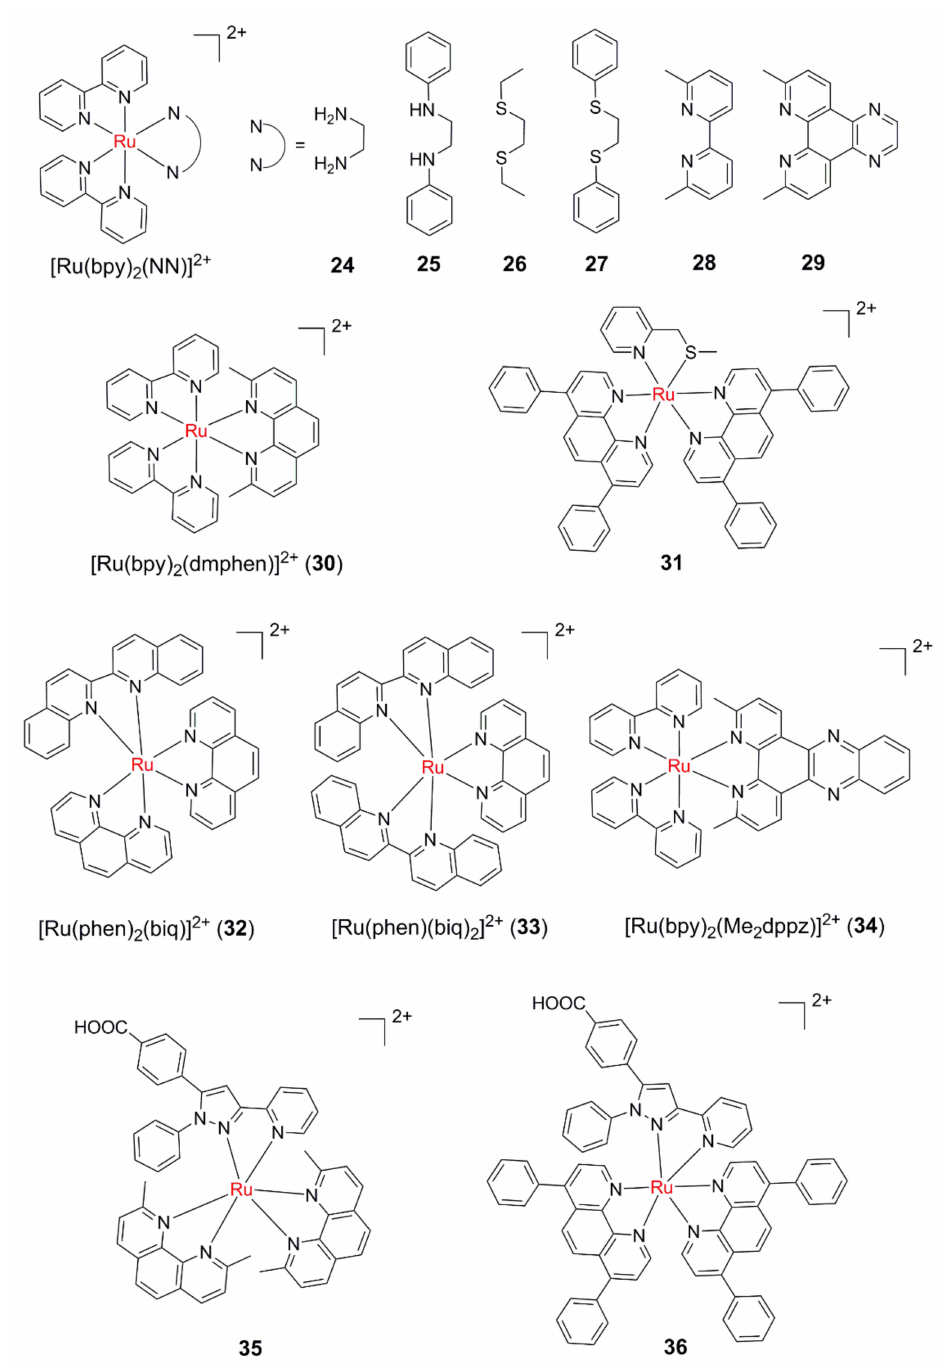
Figure 5. Ru(II) polypyridyl complexes with photolabile bidentate ligands. By taking some effective strategies, bidentate ligands can also serve as photolabile ones to expose two active sites at the same time. An effective strategy to improve the dissociation efficiency of bidentate ligands is to weaken the coordination ability of the coordination atoms. For example, compared with 24 and 25 , the photodissociation quantum efficiency of weaker bis-thioether ligands in 26 and 27 increase significantly, which are 0.019 and 0.016, respectively [62]. These two complexes can effectively reduce the